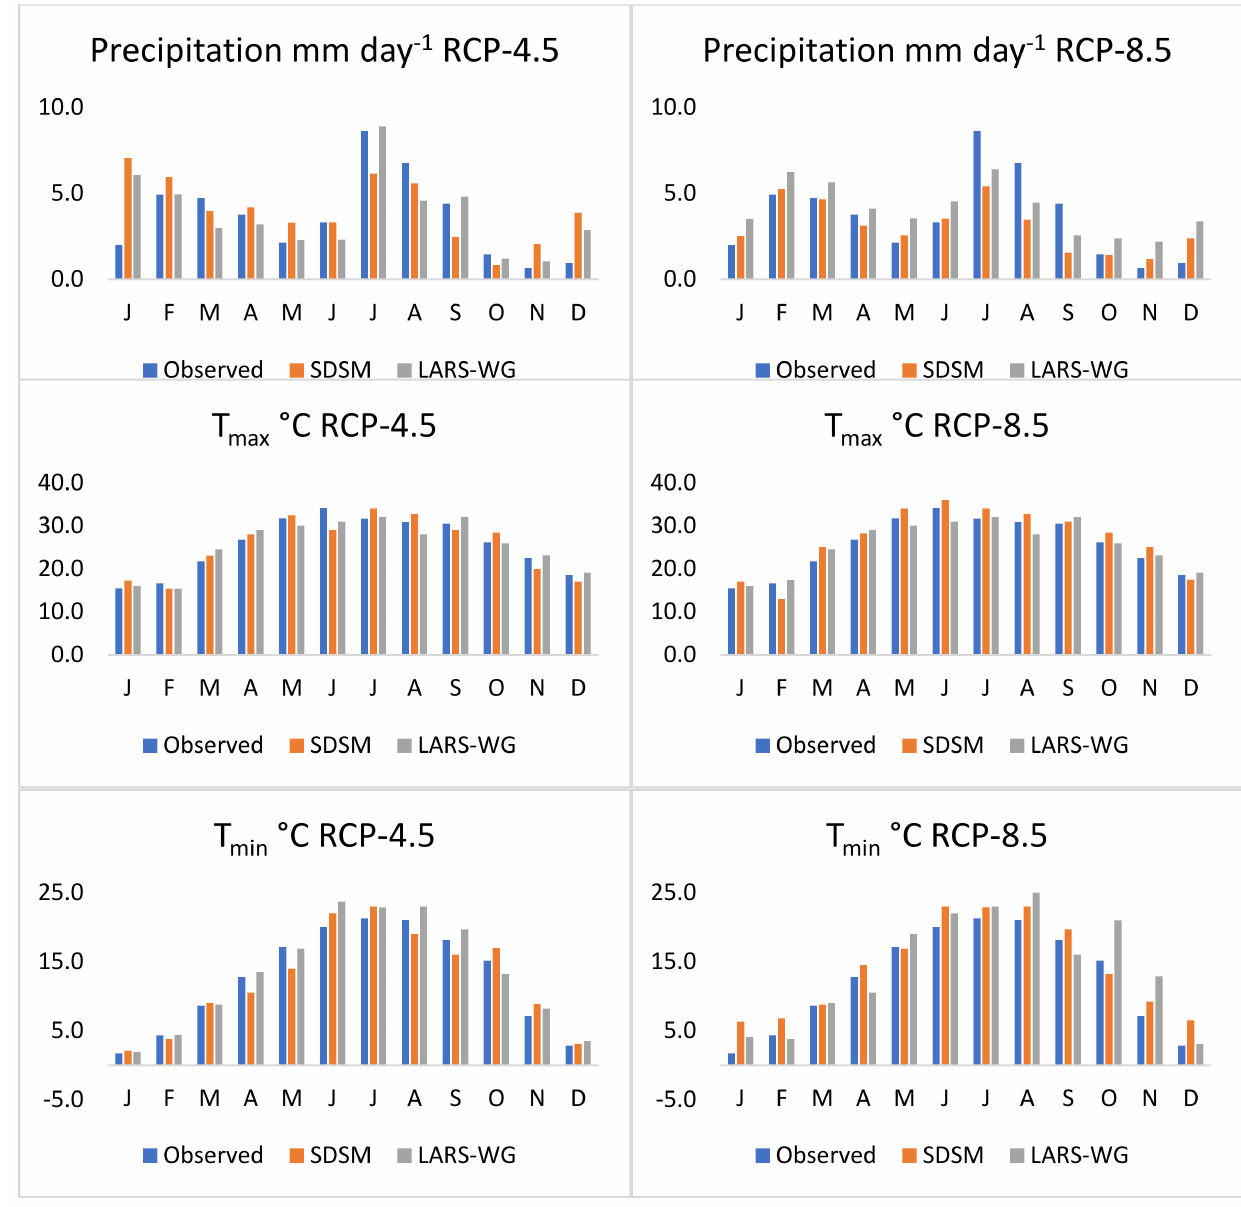
Figure 3. Calibration results of SDSM and LARS-WG models (1976–2005). The statistical downscaling models (SDSM and LARS-WG) were validated for the period of (2006–2020) by using statistical measures MAE, RMSE, bias, KGE and NSE. These measures were weighed as discussed in the Materials and Methods section following Equation (15). The values for the statistical errors were rescaled between 0–1 to avoid negative values for the precipitation. The performance assessment of the models for the validation for each of the climatic parameters are described in Table 8. The results of statistical measures proved SDSM as more efficient (0.67) in comparison to the LARS-WG (0.51) for the validation period for the Jhelum River basin. SDSM was further applied to generate future climate changes for the 21st century due to its better performance. The validation results for RCPs were in line with the calibration period and RCP-8.5 was exaggerated in comparison to the RCP-4.5 (Table 8). The simulated indicator T max proved best during the validation and precipitation was depicted the least accurate due to its complex nature (Table